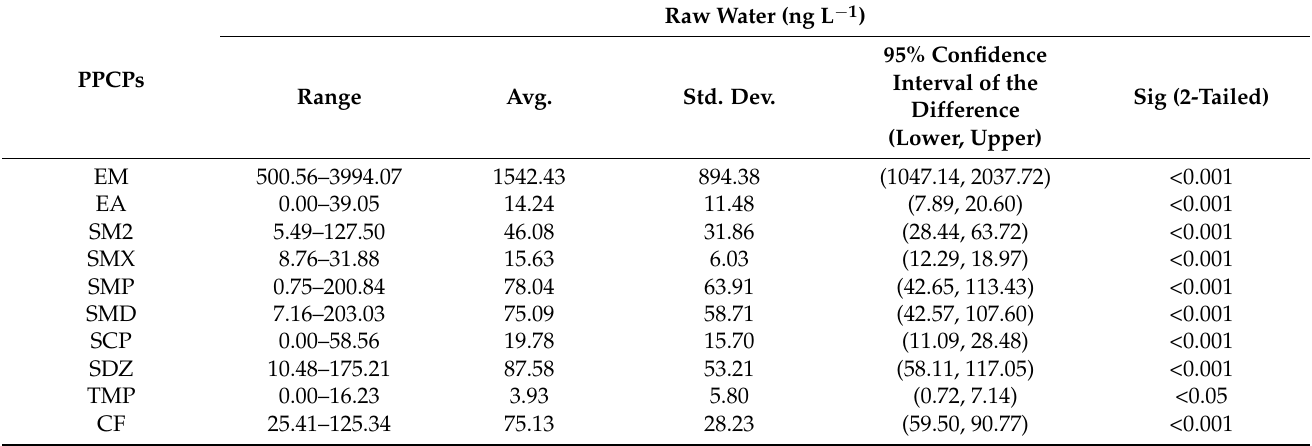
Table 2. Concentrations of typical antibiotics in the raw water (significant value, 0.05; sample size ( n ), 15).